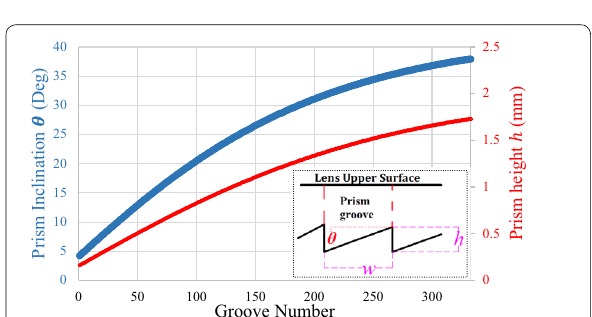
Fig. 10 Prism inclination (Blue: thick curve) and prism height (Red: thin curve) of the Fresnel lens calculated at the converging chromosome by Qandil and Zhao (2018) algorithm for the Stirling engine application